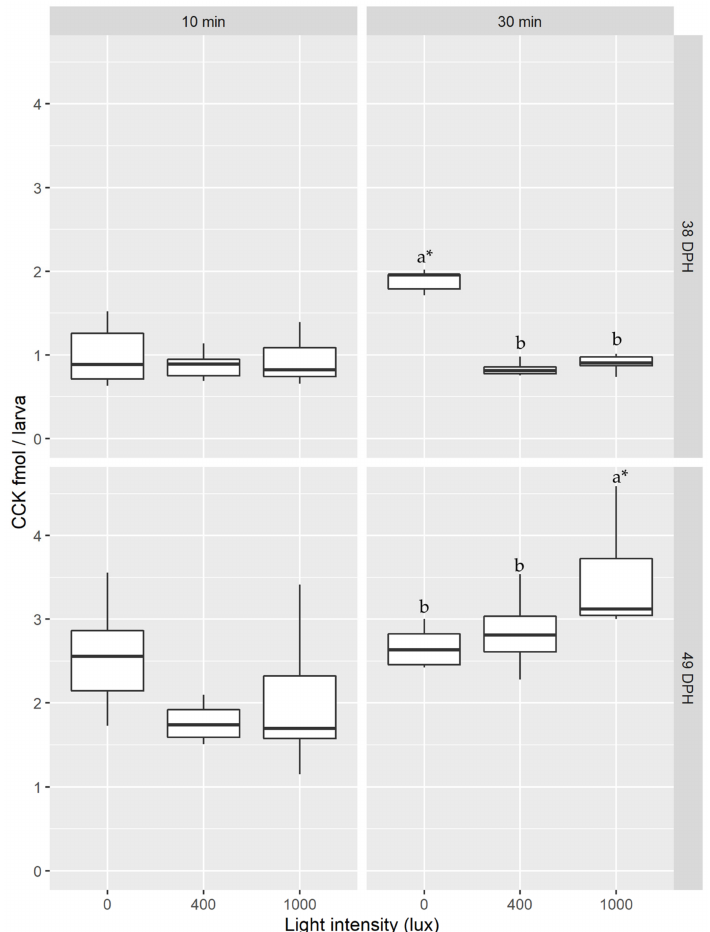
Figure 5. Variation in CCK levels in Sparus aurata larvae, aged 38 and 49 days post-hatching (DPH), 10 and 30 min after being fed under different light conditions. Different letters represent significant differences among light treatments, whereas asterisks represent differences between 10 and 30 min for each treatment and age (ANOVA, p < 0.05). Boxplot: black horizontal line represents the median, the lower and upper white boxes represent 1st and 3rd quartile, the inferior and superior extremes of whiskers represent minimum and maximum values, respectively, and the black dots represent